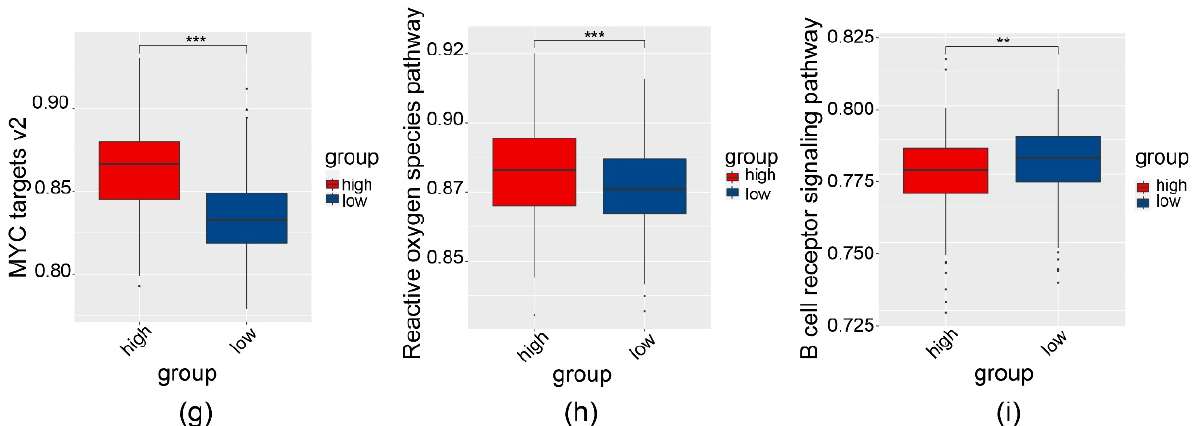
Figure 5. Gene set variation analysis to compare key molecular features between high- and low-risk groups. Significant differences in cellular and molecular features between the two groups are as